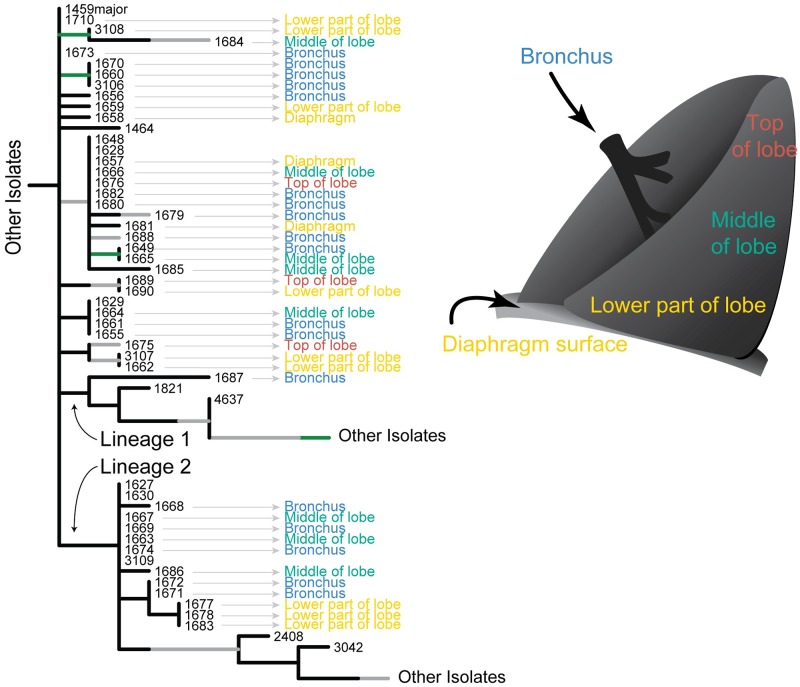
Spatial dynamics.Tree showing location of lobectomy samples suggest one non-segregated population. Samples from the same region are found across clades on the tree and multiple clades each contain samples from multiple sites.